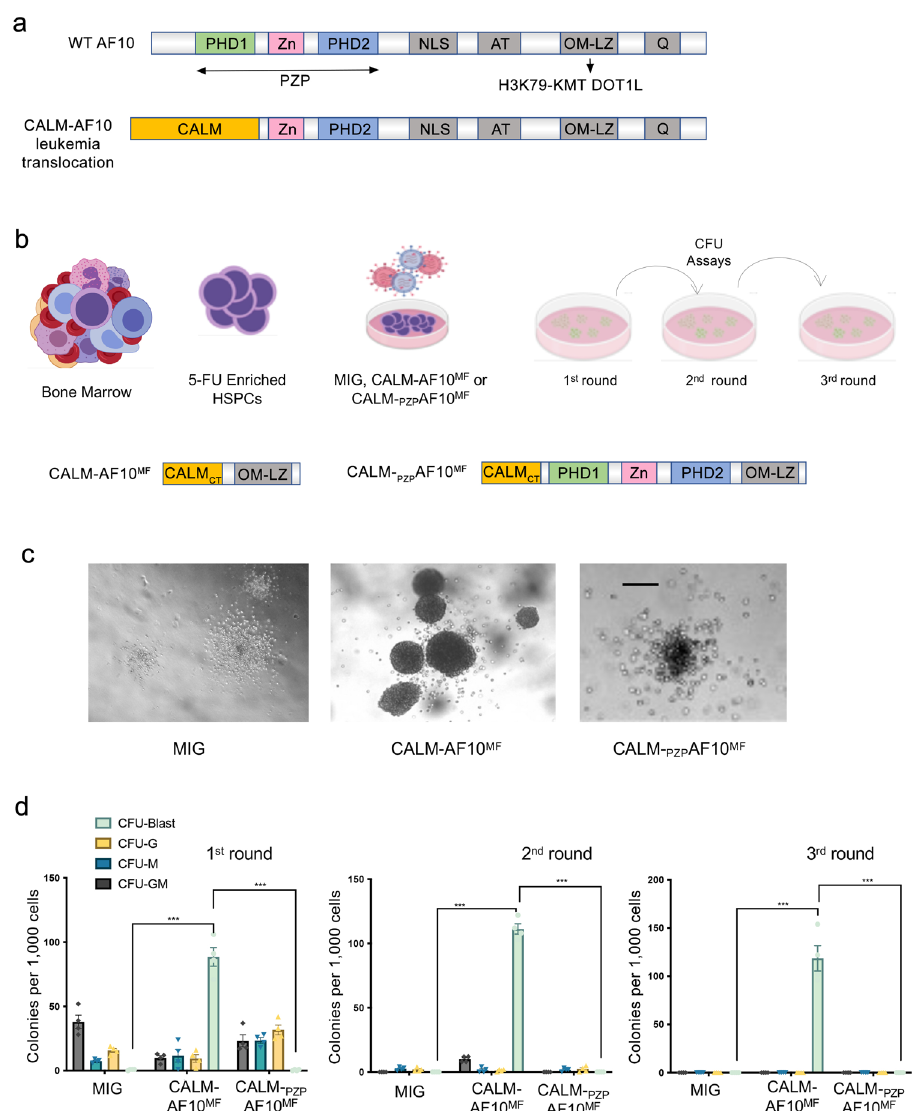
Fig. 1 AF10 PZP blocks transformation by the CALM-AF10 fusion. a The architecture of WT AF10 and the CALM-AF10 fusion. AF10 PZP , comprised of PHD1, Zn-kn, and PHD2 (colored light green, pink, and light blue, respectively) is consistently disrupted in leukemogenic AF10 translocations. The H3K79-speci fi c lysine methyltransferase (KMT) DOT1L binds to AF10 OMLZ . b Schematic of the CFU assay, with the architecture of CALM-AF10 MF and CALM- PZP AF10 MF shown at the bottom. c Images of representative one-week CFU assay colonies from bone marrow-derived HSPCs transduced with each of the indicated constructs are shown at ×40 magni fi cation. Scale bar: 100 μ m. CFU assays performed in HSPCs isolated individually from 3 mice. d Different types of colonies from cells expressing each of the indicated plasmids are shown at 3 consecutive rounds of plating. CFU-G: colony-forming unit-granulocyte, CFU- M: colony-forming unit-macrophage, CFU-GM: colony-forming unit granulocyte monocyte, CFU-Blast: blast-like colonies. P values of CFU-Blast colonies (MIG vs. CALM-AF10 MF ) and (CALM-AF10 MF vs. CALM- PZP AF10 MF ) are 0.000019 for week 1, 0.00001 for week 2, and 0.000101 for week 3 (Student ’ s t